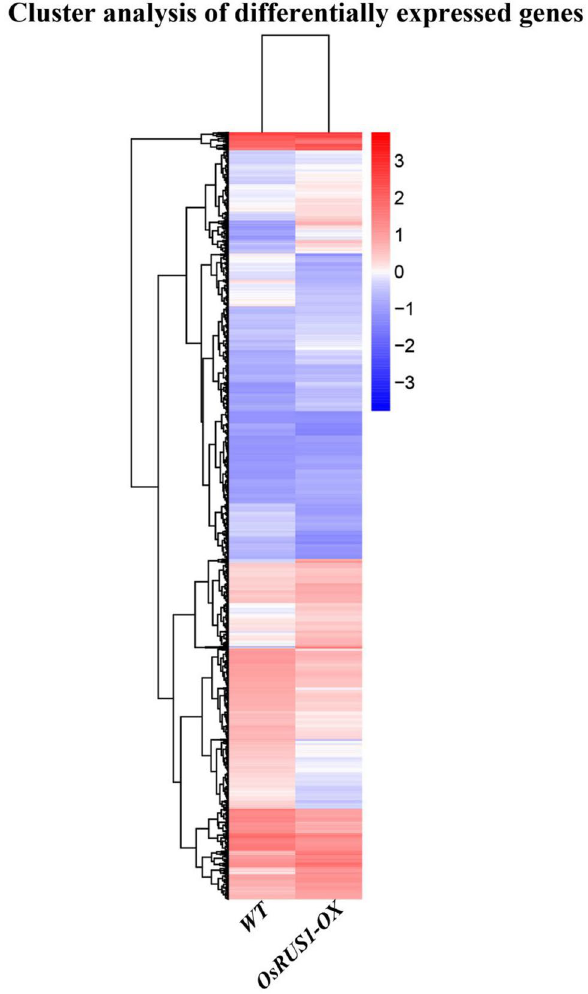
Figure 3. Hierarchical clustering of the differentially expressed genes between WT and OsRUS1-OX. The RNA-seq data derived from WT and OsRUS1-OX based on log 10 (FPKM + 1) values were utilized. The blue bands represent down regulated genes, and the red bands represent up regulated genes. WT, the wildtype of ZhongHua11; OsRUS1-OX , the OsRUS1-GFP Overexpression